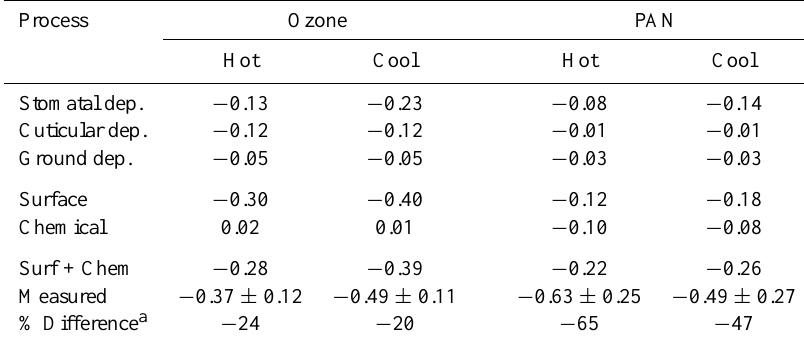
Table 6. Contributions to modeled ozone and PAN exchange velocities (cms − 1 ) . For these species, the “surface” contribution is equivalent to total deposition. Model results are taken from the layer closest to the measurement height (12.5m for O 3 , 17.8m for PAN). Measurements are given as the mean ± 1 σ